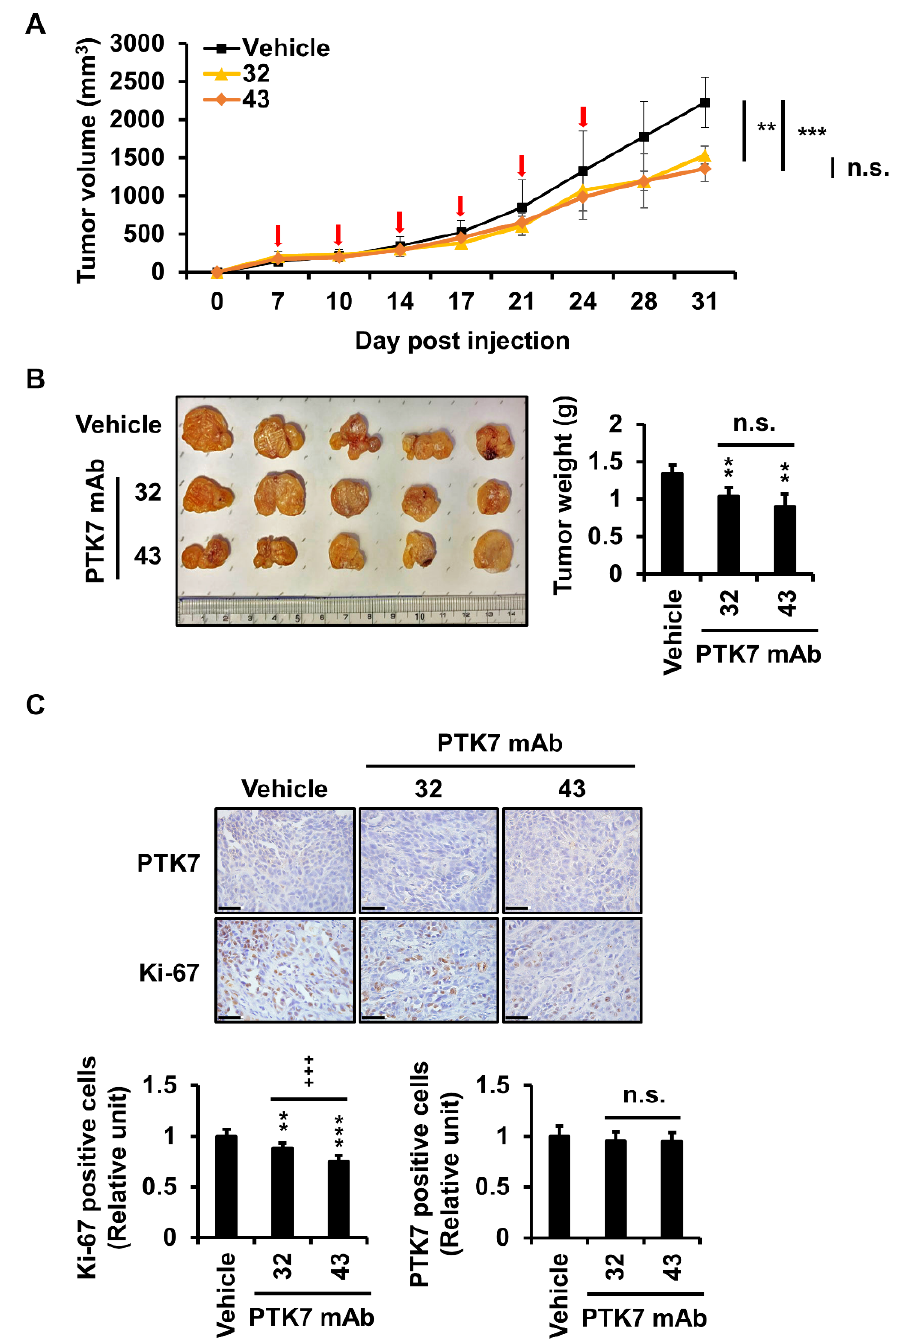
Figure 6. PTK7 mAbs inhibit tumor growth in an ESCC xenograft mouse model. A xenograft mouse model of ESCC was established by the subcutaneous injection of KYSE-30 cells into the dorsal regions of nude mice. When cell masses were recognized after cell injection, PTK7 mAb (10 mg/kg) was injected intraperitoneally twice a week for three weeks. The mice were sacrificed 7 days after PTK7 mAb injection and the tumors were excised. ( A ) Tumor volume was measured in the xenograft mice. ( B ) Images of tumors excised from sacrificed mice. Tumor weight is shown on a graph. Each bar represents the mean ± SD of five mice. ( C ) IHC staining of PTK7 and Ki-67. Representative images are shown. The scale bar represents 50 µ m. Protein levels in IHC images were quantitated using ImageJ software. Each bar represents the mean ± SD of five mice: ** p < 0.01 or *** p < 0.001 vs. vehicle; +++ p < 0.001 or n.s. (not significant) between PTK7 mAb-32 and PTK7